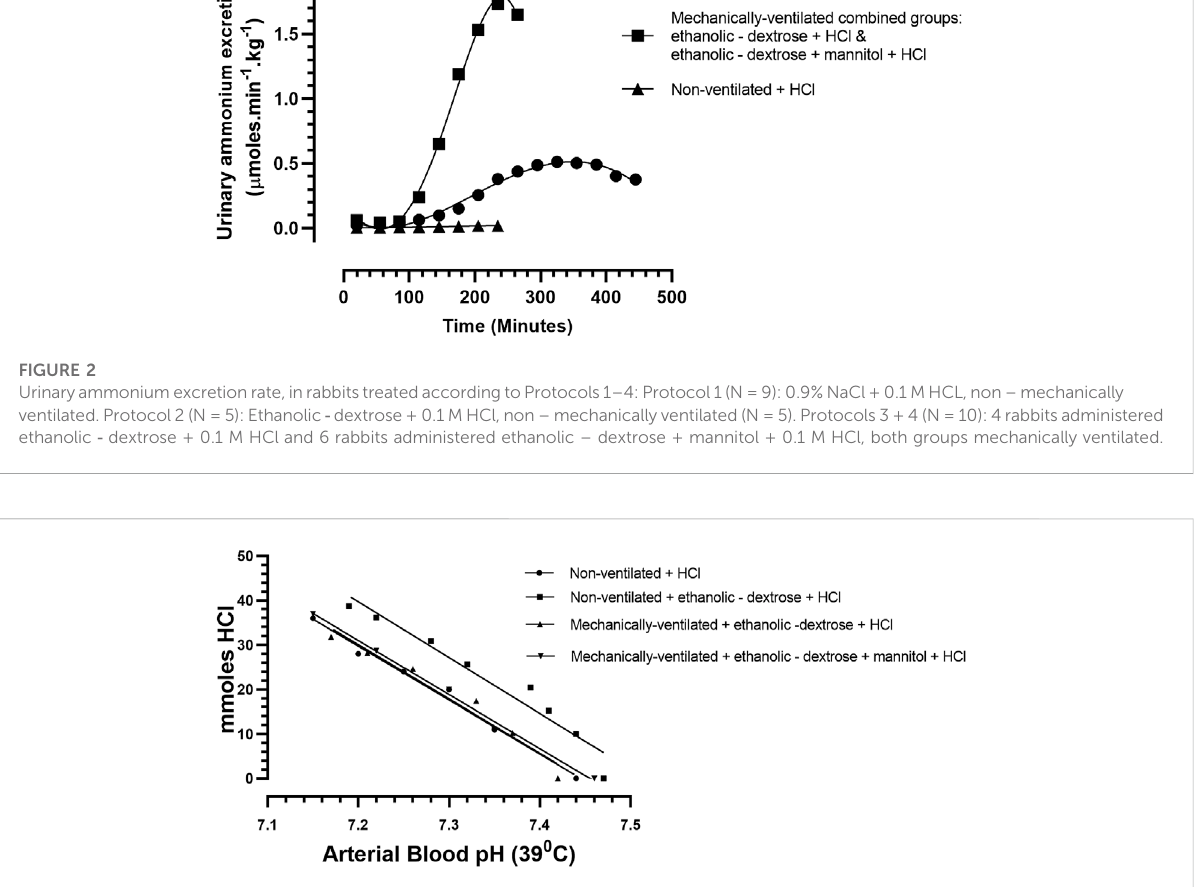
FIGURE 3 The titration of arterial blood at 39 ° C in each of four different rabbit subgroups, each having received a regimen, according to Protocols 1 – 4: Protocol 1 Control Group (N = 9): 0.9% NaCl + 0.1 M HCL, non – mechanically ventilated. Protocol 2: Ethanolic - dextrose + 0.1 M HCl, non